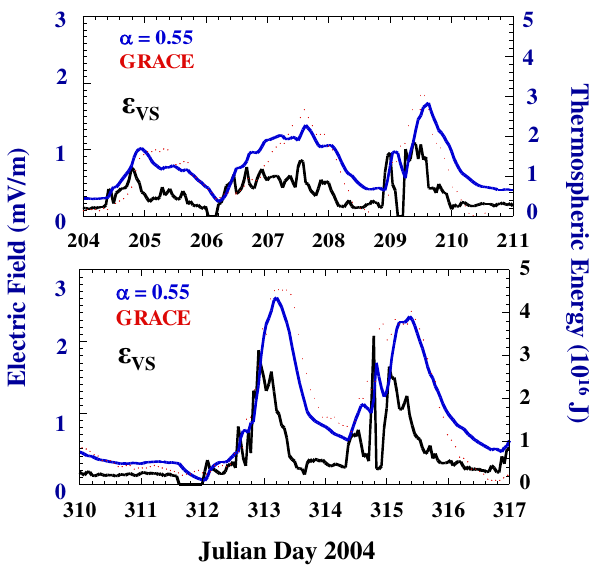
Fig. 7. Comparison of ε VS (black), modeled E thSW (blue) and values inferred from density measurements by GRACE (red) plotted as functions of time during magnetically disturbed periods of July (top) and November (bottom) 2004. Energies are expressed in units of 10 16